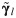
Overview of GMA.Prior studies provide the vector of empirical signatures, γ˜l. The hypothesized meta-model is estimated by simulating those signatures and matching them against empirical ones.